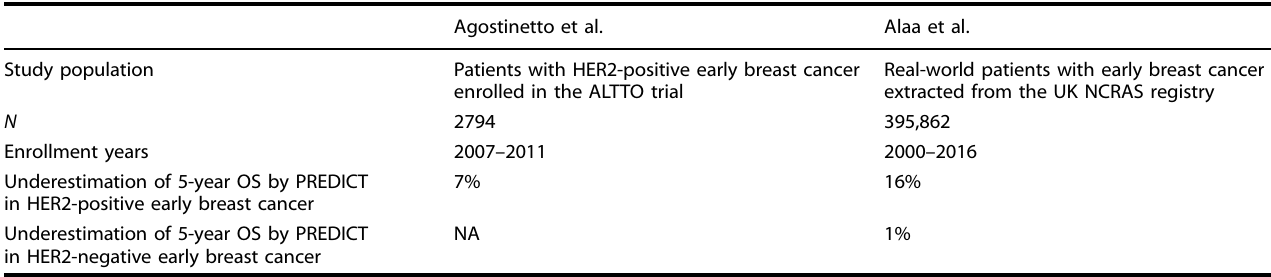
Table 1. Magnitude of survival underestimation by PREDICT in the study by Agostinetto et al. and in the one by Alaa et al. Agostinetto et al. Alaa et